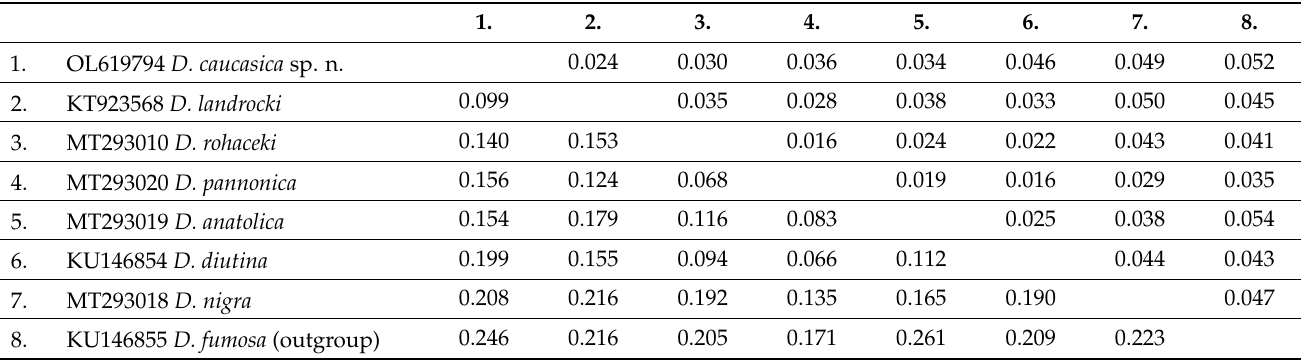
Table 1. Table showing the pairwise Kimura 2-parameter distances between sequences [25]. Standard error estimates are shown above the